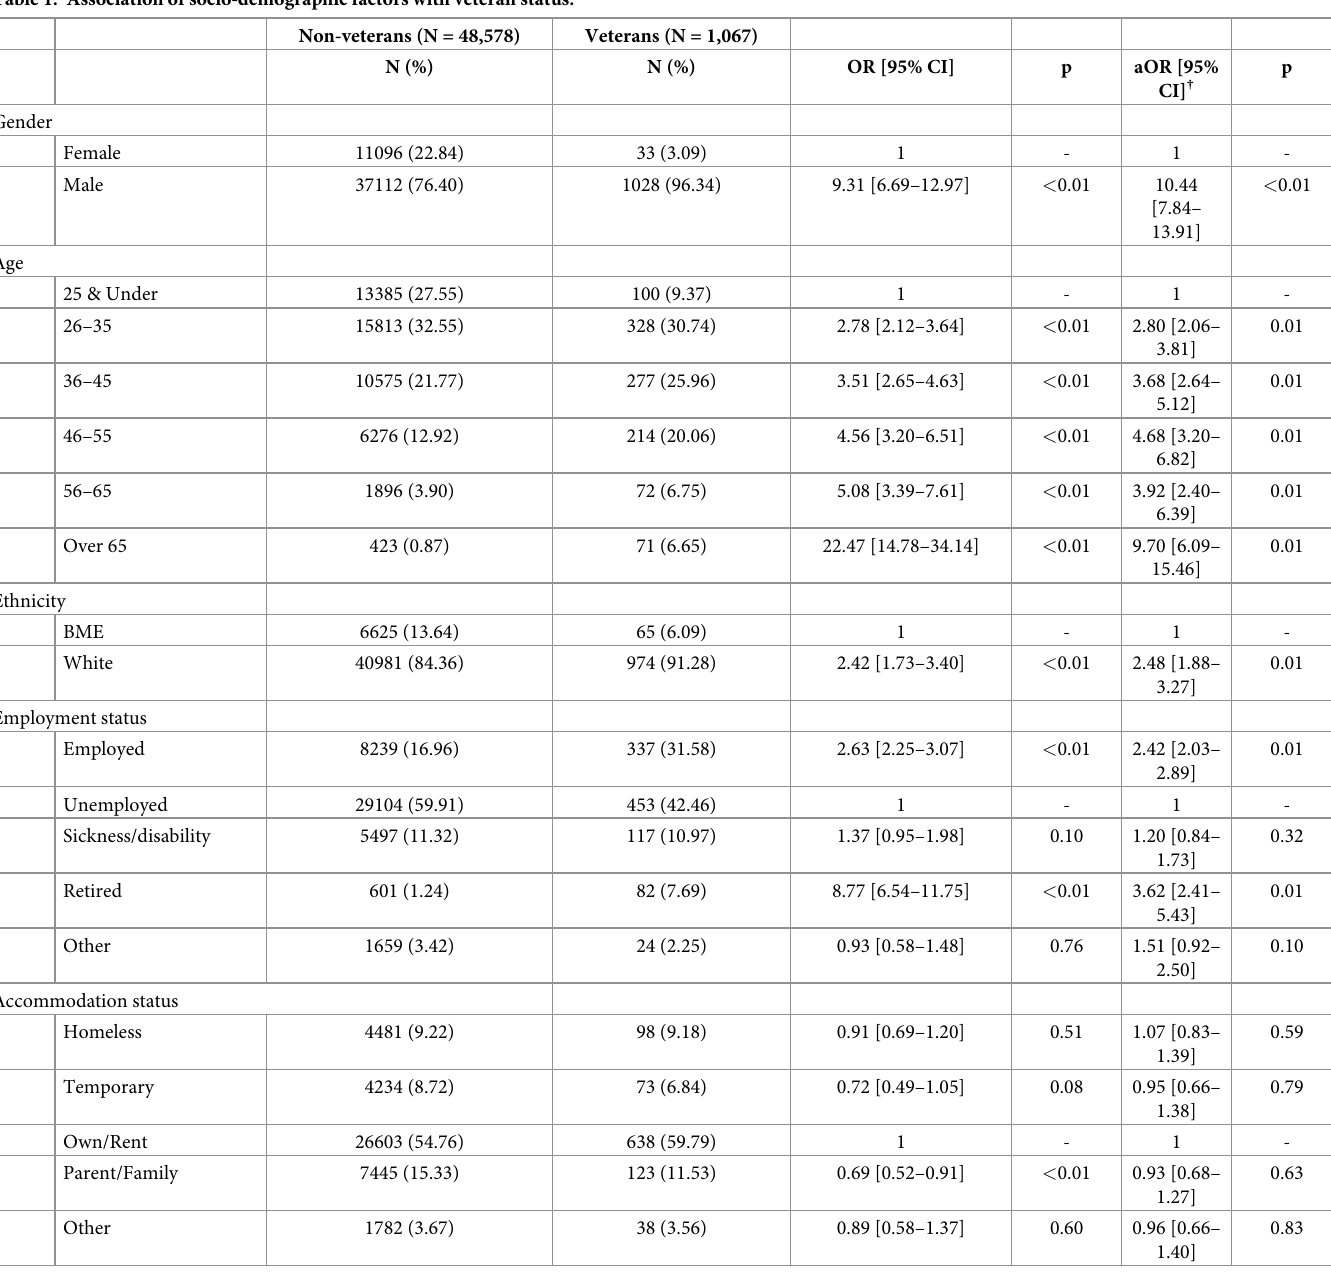
Table 1. Association of socio-demographic factors with veteran